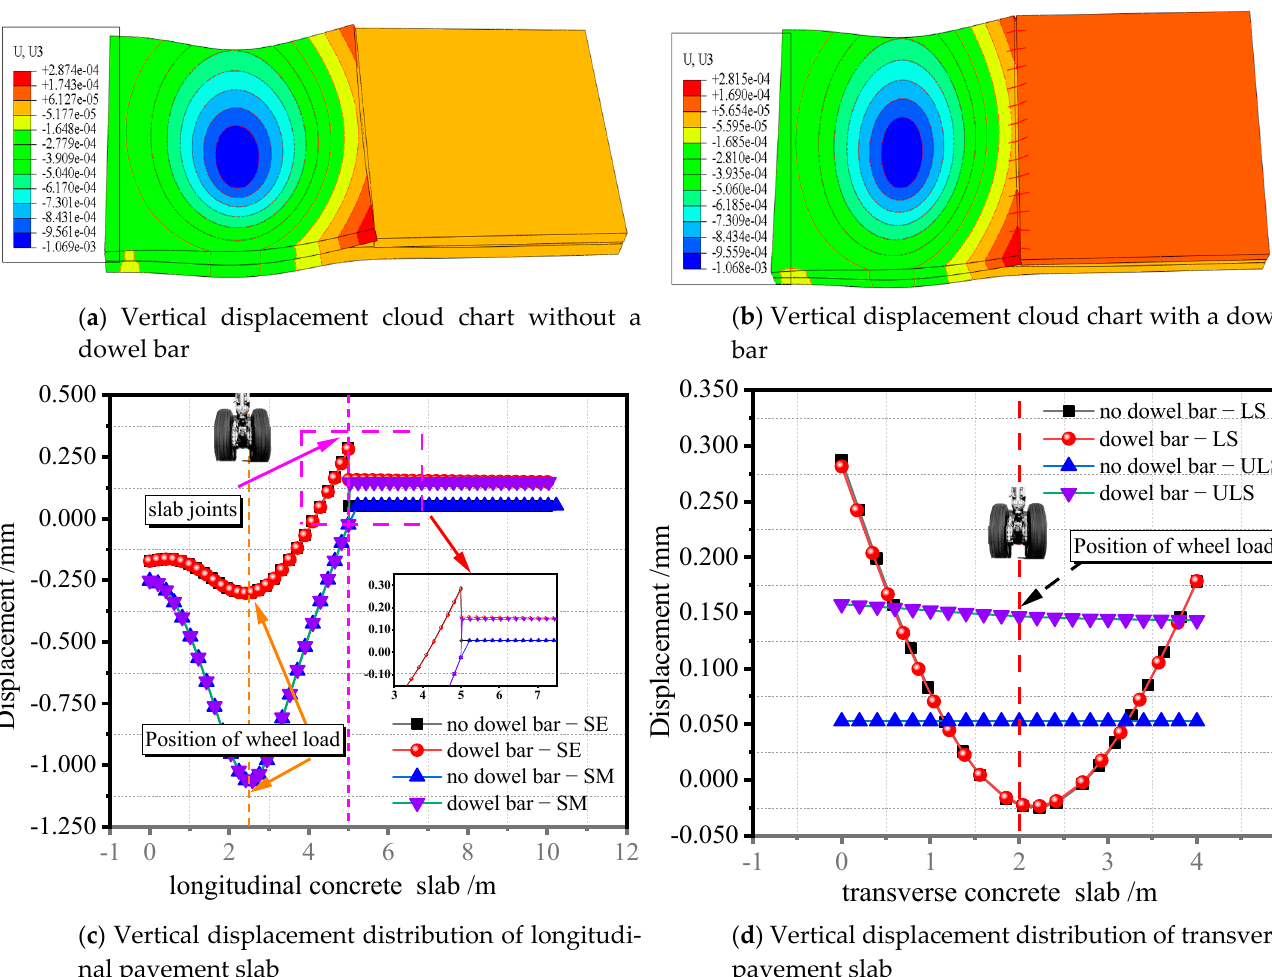
Figure 7. Displacement distribution of the aircraft’s wheel load acting on the pavement slab. The vertical displacement at the center of the laden slab’s longitudinal edge is 0.31 mm, whereas the edge of the slab is 0.17 mm. The attenuation coefficient is 45.16%. Here, in the transverse direction of the loaded slab, the vertical displacement between the wheel load and slab edge increases by 0.28 mm. Figure 7 shows that there is an upward warping deformation along the slab’s edge, and Figure 7c,d also demonstrate that there is an up- ward warping deformation at the joint between the adjacent slabs. The warping defor- mation displacement of the loaded slab’s edge is 0.28 mm, and that of the empty slab is 0.05 mm when there is no dowel bar. The displacement caused by warping when a dowel bar is present is 0.28 mm for the loaded slab’s edge and 0.15 mm for the unloaded slab’s edge. Hence, we may conclude that when the dowel bar is introduced, the adjacent slabs share a portion of the load, the deformation of the laden slab occurs on the opposite side, and the deflection load transfer coefficient of the dowel bar is 56.03%.